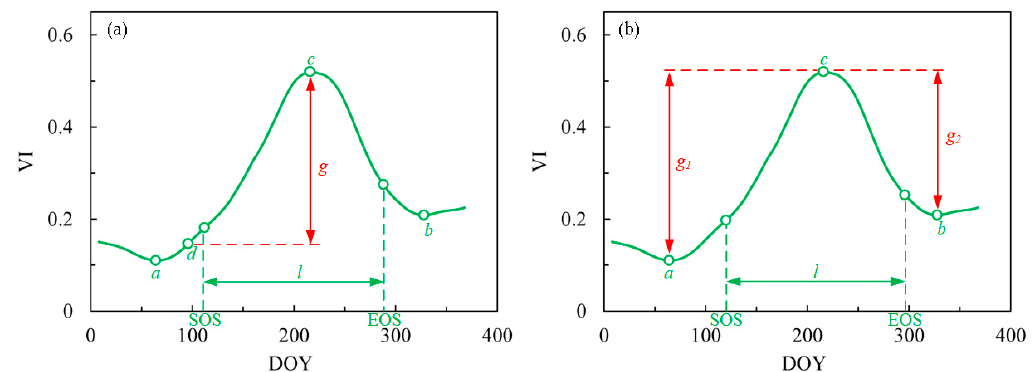
Figure 2. Illustration of the dynamic threshold method before ( a ) and after modification ( b ), x-axis represents Day of Year (DOY), and y-axis represents the Vegetation Index (VI). Instead of using a single VI dynamic range, the modified algorithm distinguishes between ascending and descending growth curves.